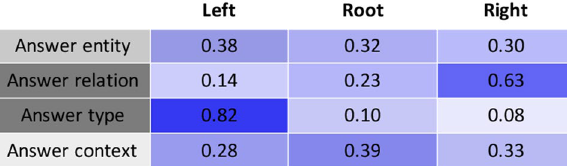
Fig. 10 Cross-attention heat